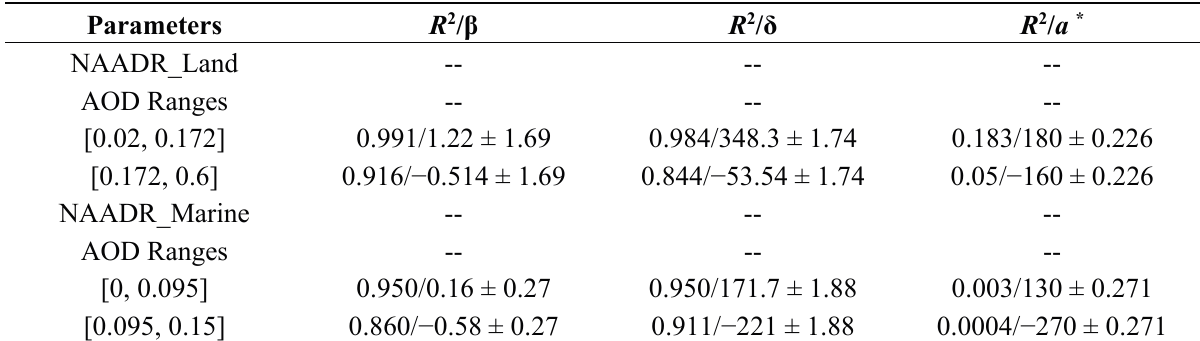
Table 1. Correlation coefficients ( R 2 ), sensitivity ( δ ), relative sensitivity ( β ) and slope ( a * ) of the regression line (before binning) of cloud water path (CWP) to increasing aerosol optical depth (AOD) as function of AOD ranges and aerosol